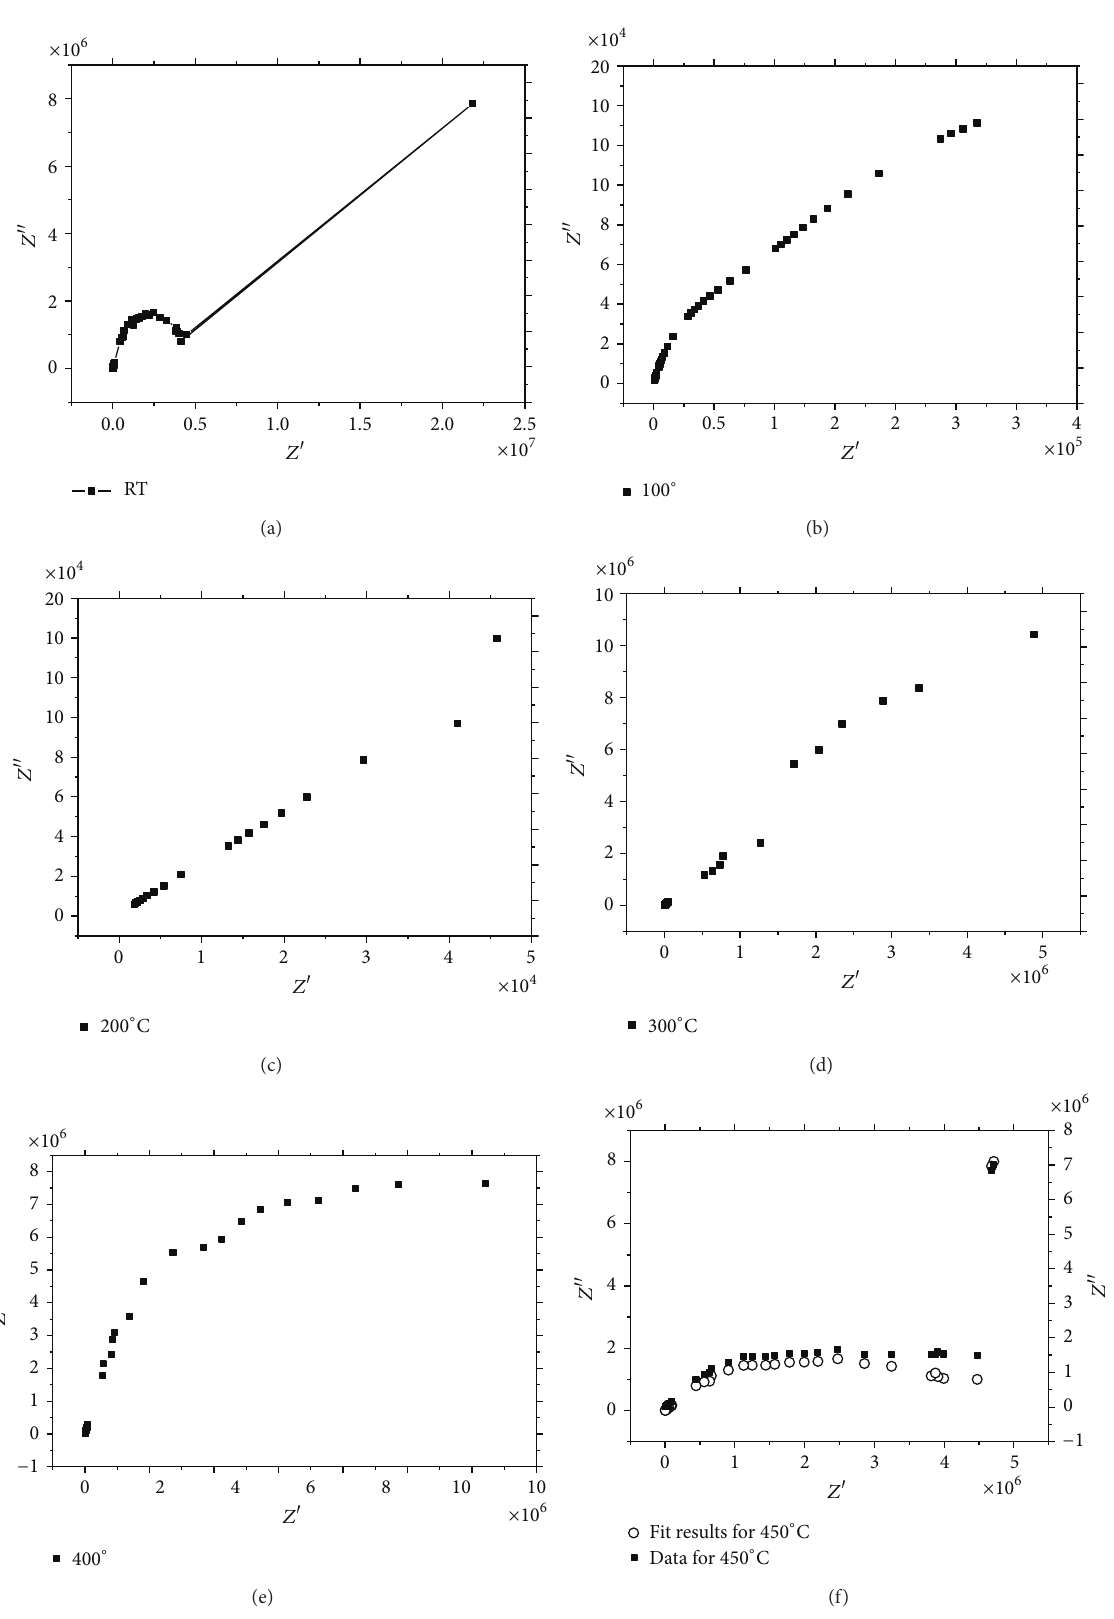
Figure 6: (a)–(e) Cole-cole plot of synthesized zirconia at different temperatures. (f) Impedance spectra plot of zirconium oxide with fit results at 450 ∘